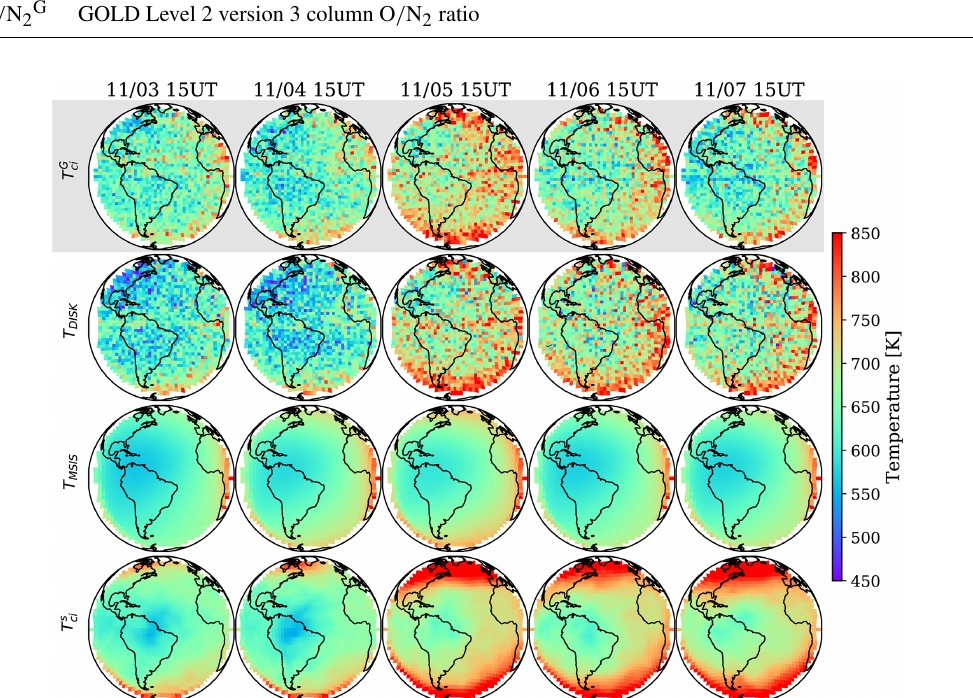
Figure 7. Comparison of T G with T DISK , T MSIS , and T ci s over Earth’s disk viewed by GOLD from 3–7 November 2018 at about 15:00UT, ci noon LT at the center of the disk (0 ◦ N, 47.5 ◦ W). A moderate geomagnetic storm ( Kp = 5 . 8, Dst = − 55nT) commenced the evening of 4 November and lasted through 5 November.